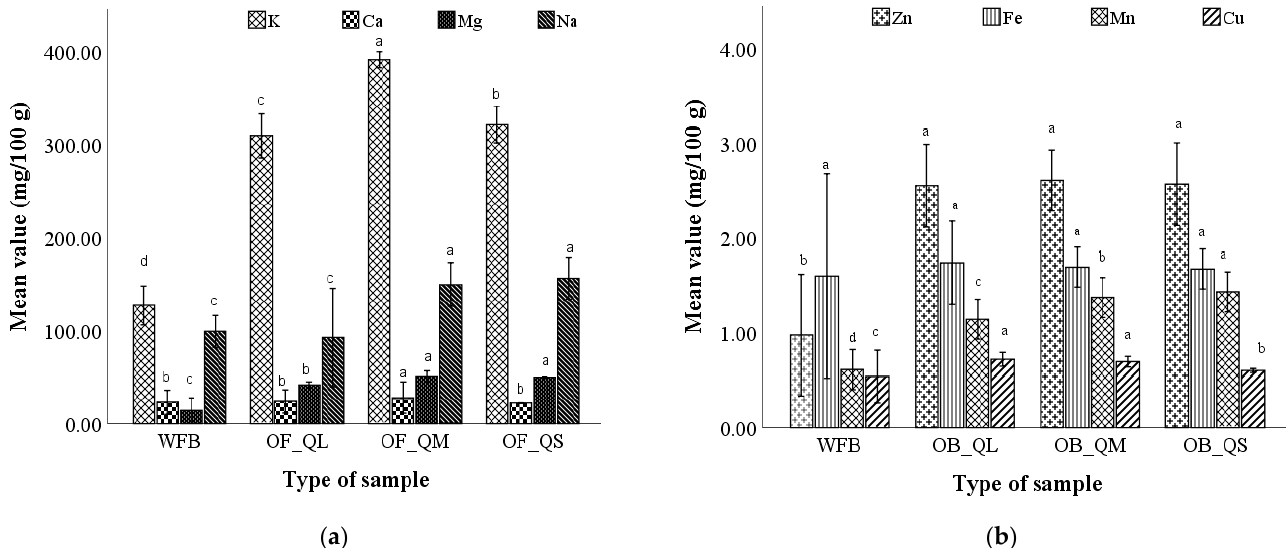
Figure 4. Macro–( a ) and micro-mineral ( b ) composition of the bread with the optimal dose of quinoa flour corresponding to the large, medium, and small particle size (OB_QL, OB_QM, and OB_QS) in comparison with wheat flour bread (WFB). Mean values followed by different letters (a–d) are significantly different ( p < 0.05).